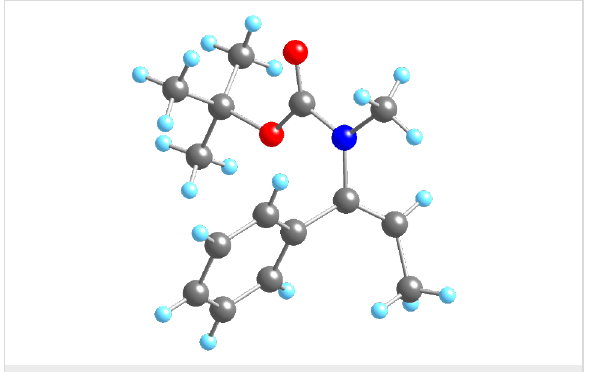
Figure 2: X-ray crystal structure of carbamate E - 10 .